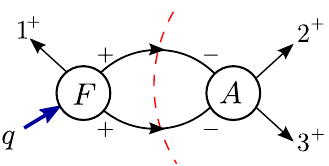
Figure 2 . Two-particle cut of the one-loop form factor F (1)